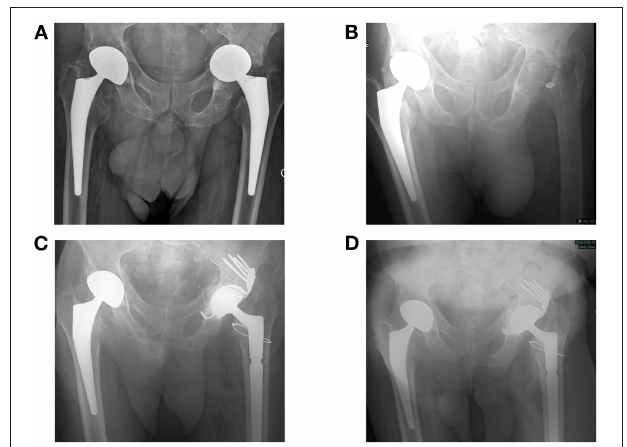
FIGURE 1 | Clinical description of the patient #4, a 77-year-old man. He had a past history of anal cancer and congestive heart failure with arrhythmia. Right and left hip prostheses were implanted in 2013 and 2014, respectively, both following femoral head fracture. As prosthesis loosening occurred with migration of the prosthesis in the pelvis (A) , a prosthetic joint infection (PJI) of the left hip was suspected. Explantation was performed in 2017 (B) , revealing P. aeruginosa chronic infection. Unfortunately, the strain was resistant to ciprofloxacin, but remained susceptible to ceftazidime. Intravenous (IV) ceftazidime was administered after explantation and stopped 15 days before reimplantation. At the time of reimplantation 3 months later, a